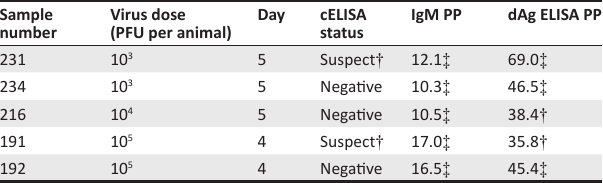
TABLE 4: Outliers as tested using the three